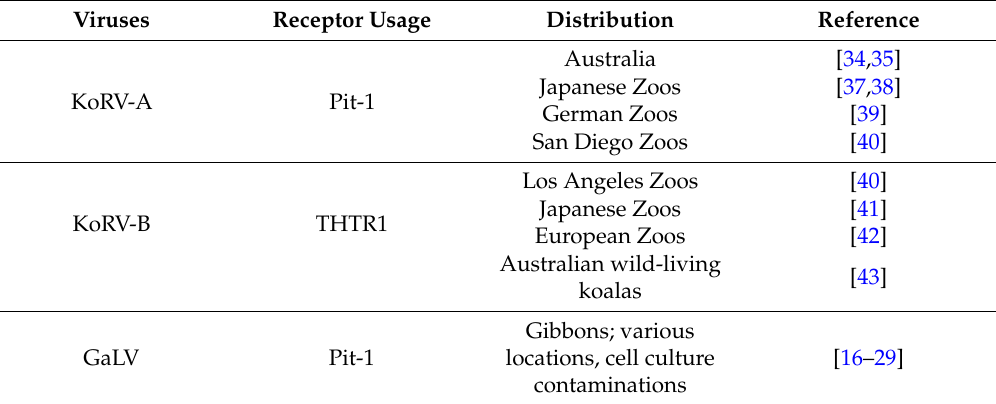
Table 1. Receptor usage and distribution of different koala retrovirus (KoRV) and gibbon ape leukaemia virus